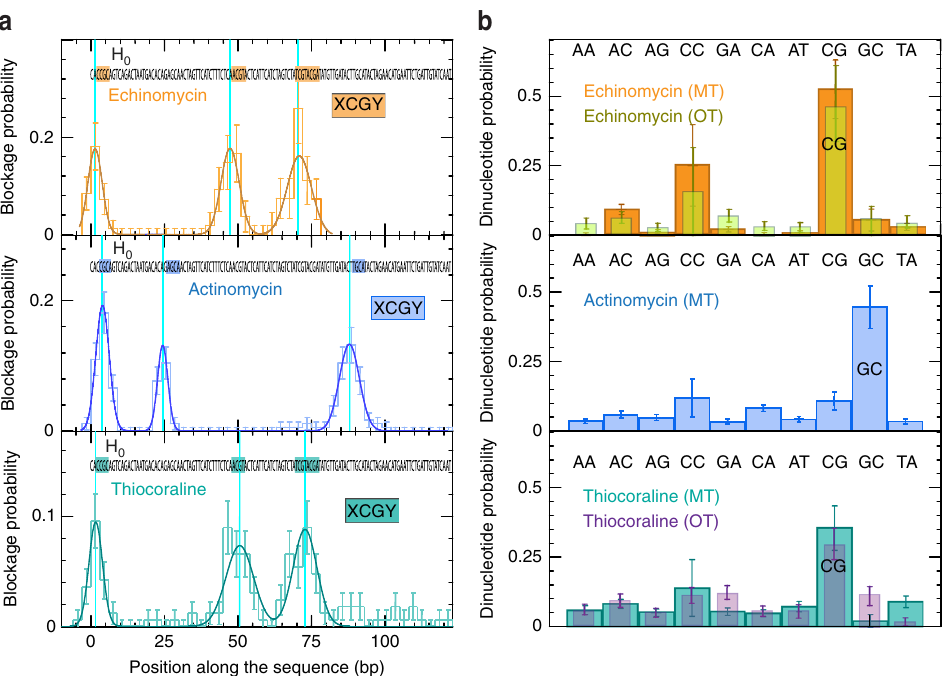
Fig. 3 Binding selectivity measurements for different intercalators. a Distribution of blockage positions obtained by applying the FC protocol on H 0 in presence of Echinomycin at 300 nM ( upper , number of beads = 93), Actinomycin at 1 μ M ( middle , number of beads = 174), and Thiocoraline at 100 nM ( lower , number of beads = 127). The blockage position for each bead is obtained from 50 to 300 cycles of the FC protocol. Error bars are inversely proportional to the square root of the number of points for each bin. The distribution is fi tted to Gaussian functions. b The probability of observing a blockage at each possible dinucleotide step for Echinomycin ( upper ), Actinomycin ( middle ), and Thiocoraline ( lower ), computed from data in a . The results for Echinomycin and Thiocoraline obtained with optical tweezers are also shown for comparison (Supplementary Fig. 6 and ref. 21 ). Error bars are inversely proportional to the square root of the number of points for each